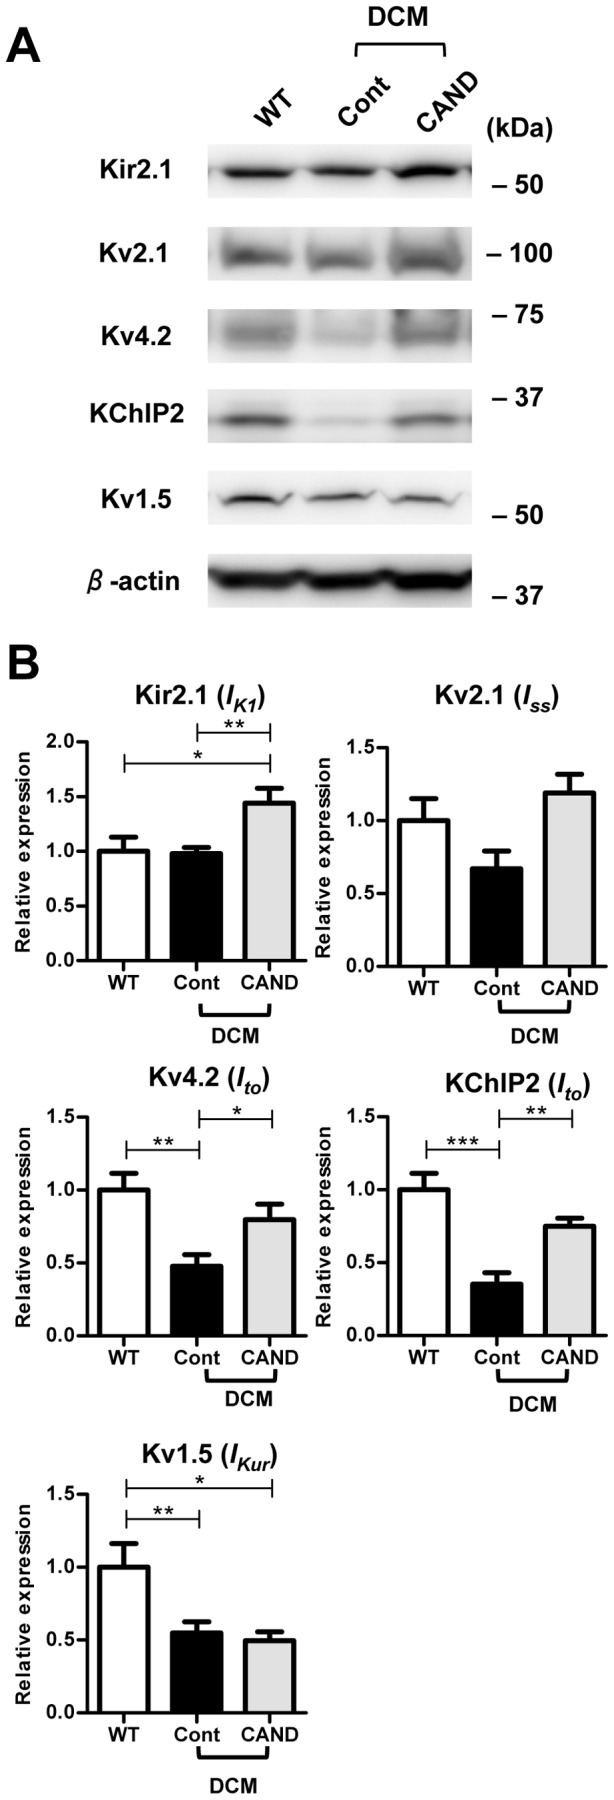
Western blot analysis of the K+ channels and auxiliary subunits in the LV.Membrane protein samples (50 µg) of WT (n = 6), control (n = 10) and candesartan-treated DCM (n = 7) LVs were separated by SDS-PAGE and western blot analysis was carried out. See Methods for details. A. Representative blots of individual experiments. B. Averaged expression levels. The relative expression levels for each protein were normalized to the average value for WT LVs. *P<0.05, **P<0.01, ***P<0.001.